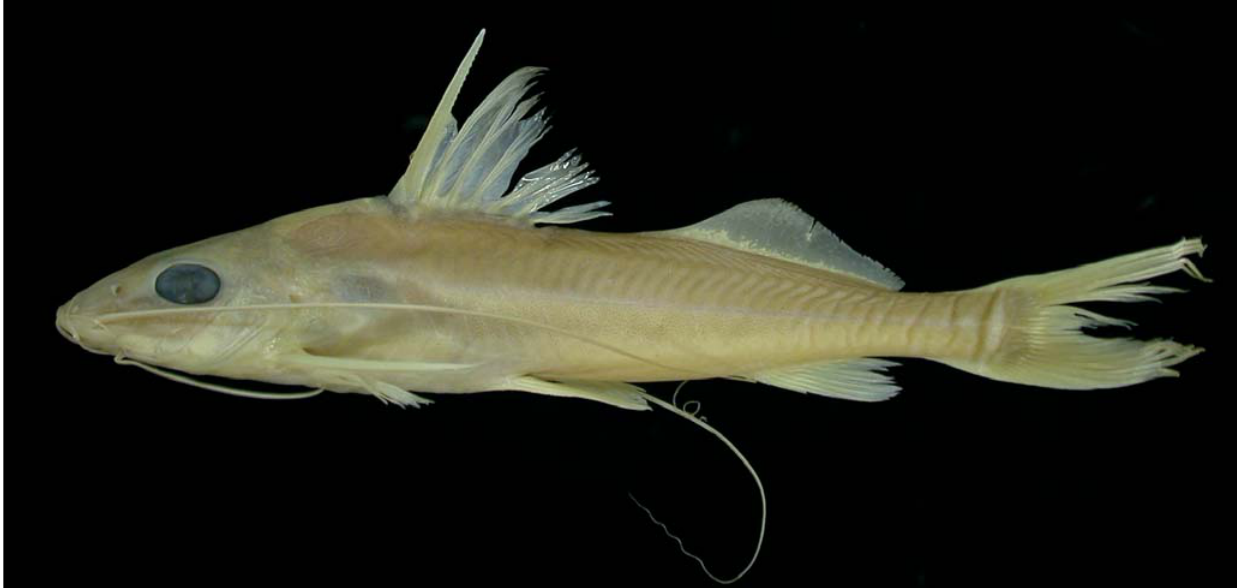
Fig. 3. Pimelodus halisodous , holotype, MCP 41738, 108.8 mm SL, rio Paranã, rio Tocantins drainage,